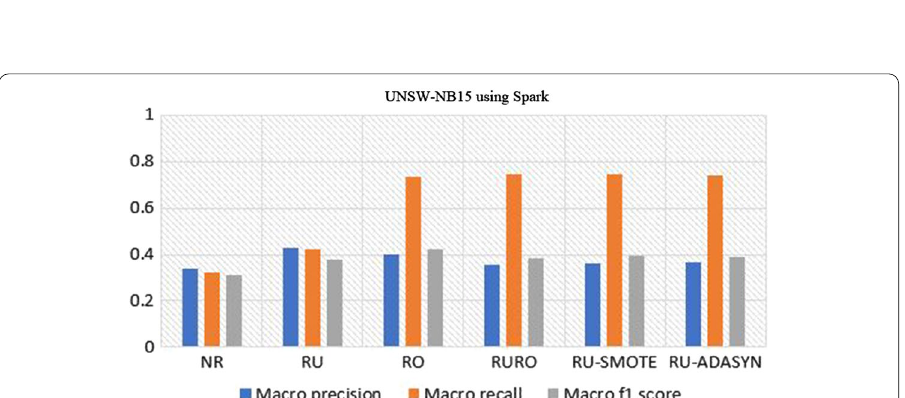
Fig. 9 ANN classification results for UNSW-NB15 on AWS with Spark for various resampling